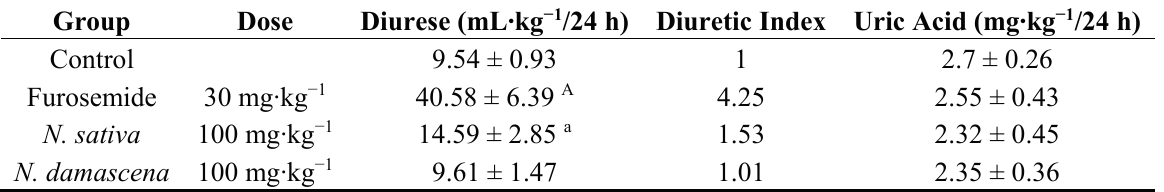
Table 4. Effect of Nigella ethanolic extracts and furosemide on urine output and uric acid in 24 h of urine collection. Drugs were given orally ( n =